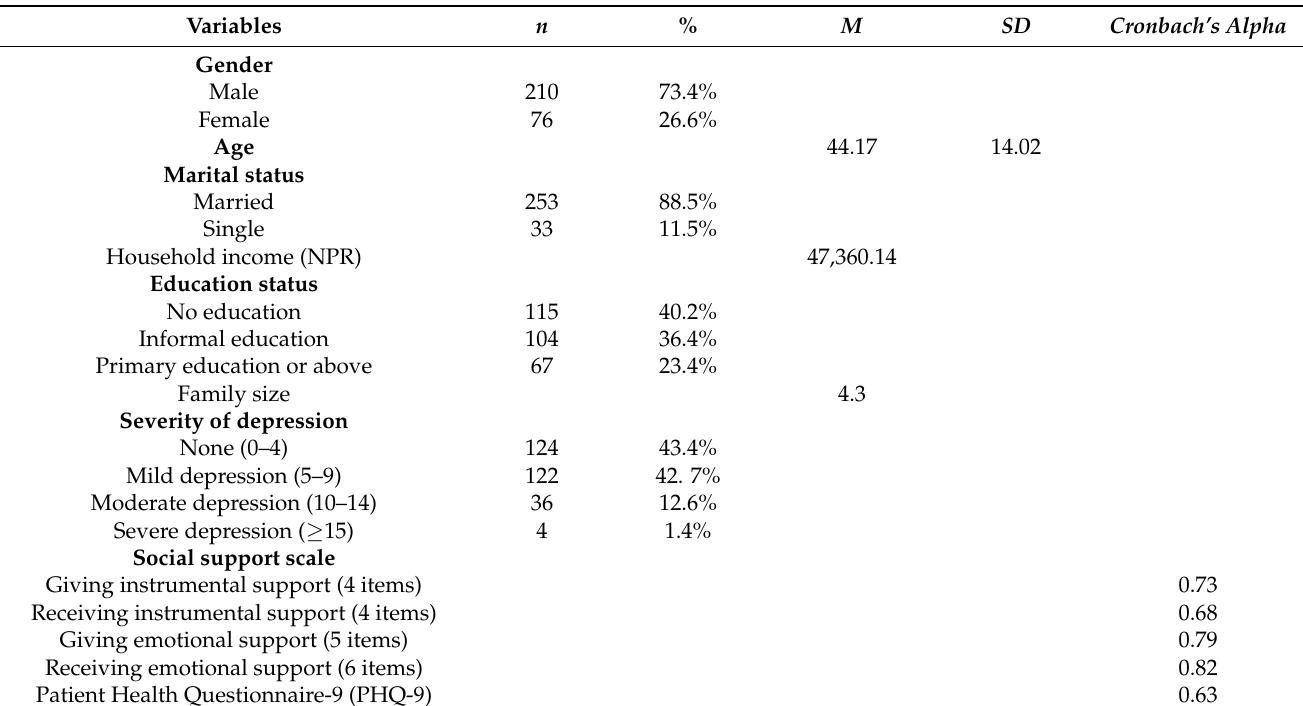
Table 2. Demographic and psychological characteristics of the sample ( n =